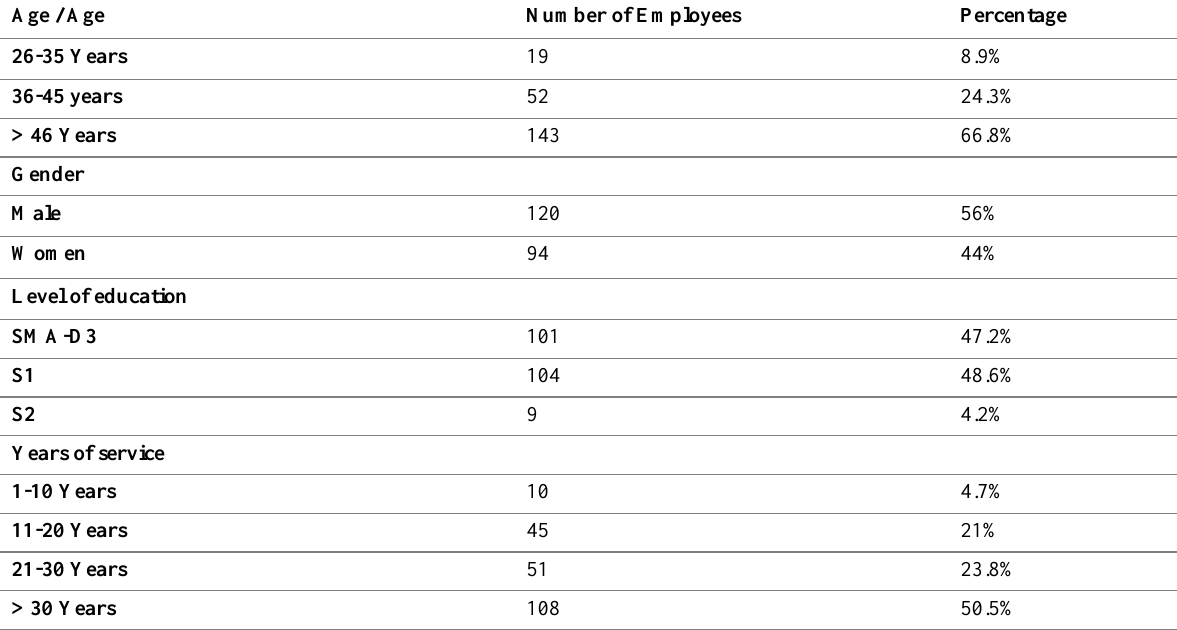
Table 2: Description of Age, Gender, Education Level and Employee Service Period